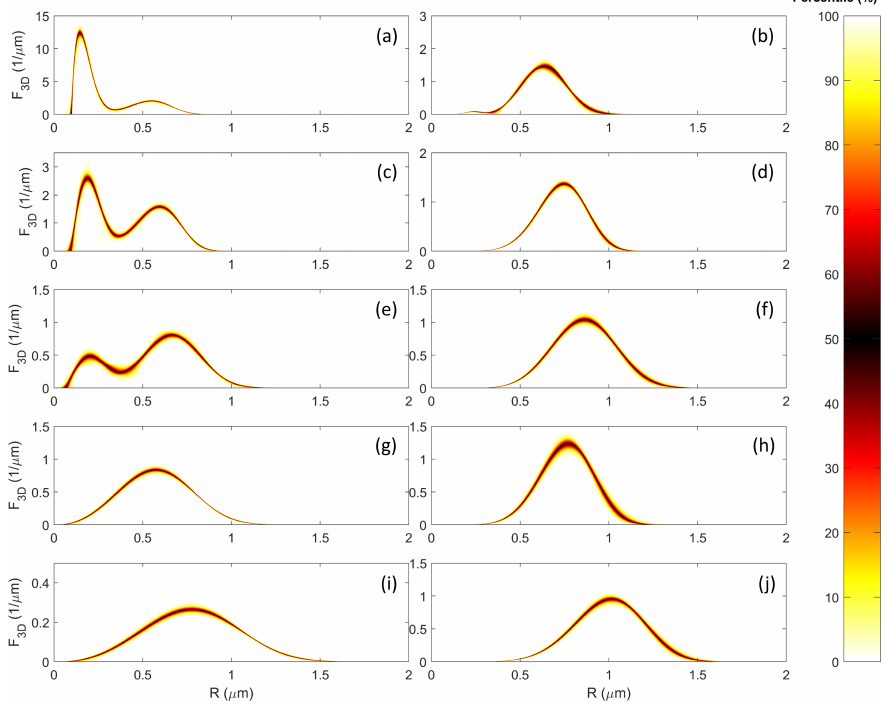
Figure 13. The scatter and variation in approximated 3D particle size distributions in γ (cid:48)